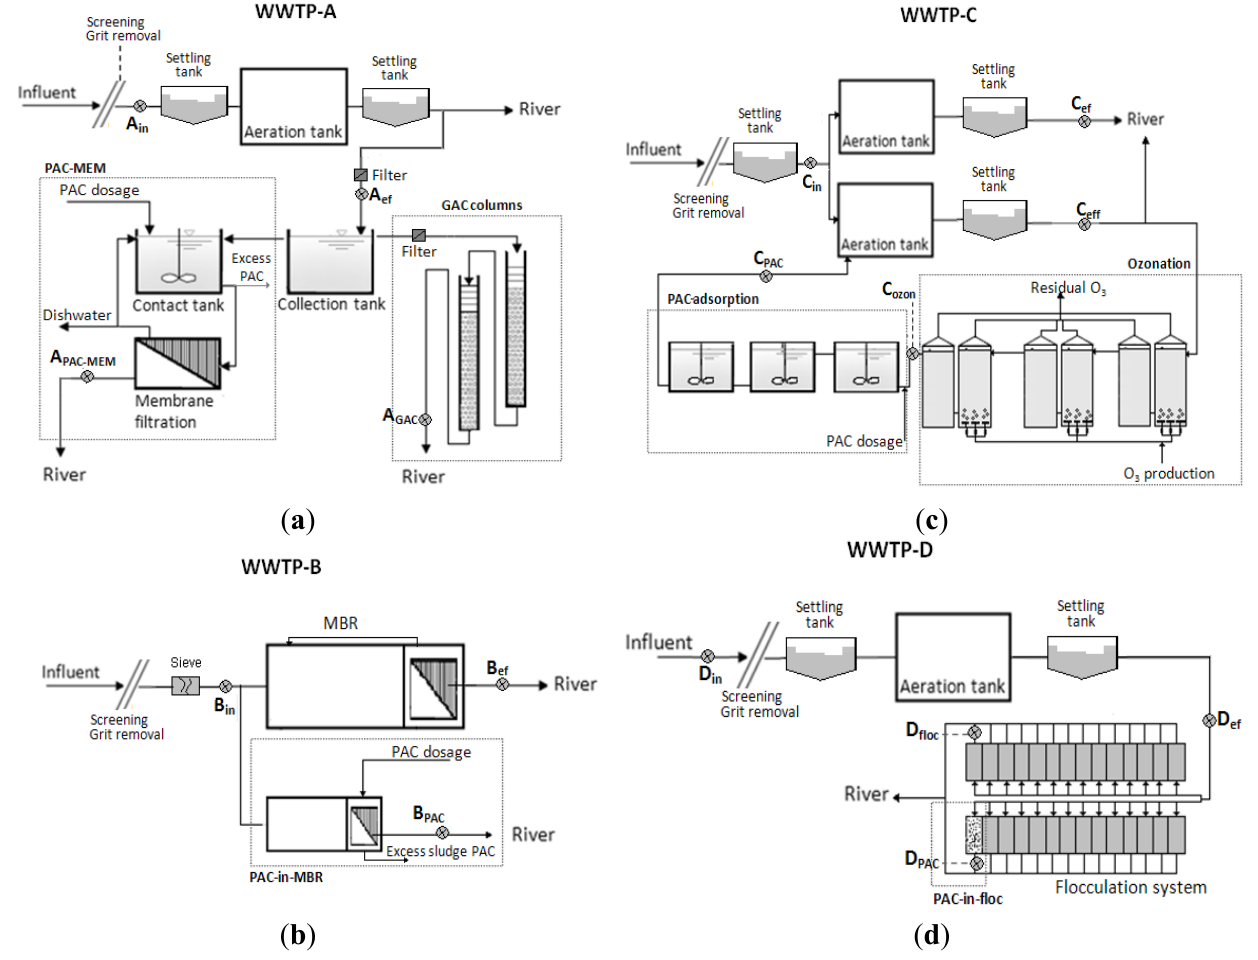
Figure 1. Schematic diagrams of the selected WWTPs ( a ) WWTP-A; ( b ) WWTP-B; ( c ) WWTP-C; ( d ) WWTP-D and the pilot-/full-scale projects. Sampling points are indicated by a